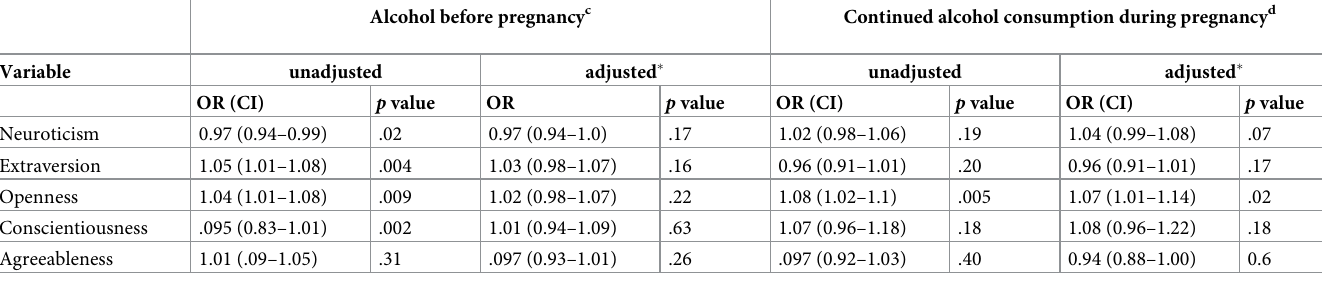
Table 3. Associations between women’s personality and alcohol consumption before and during